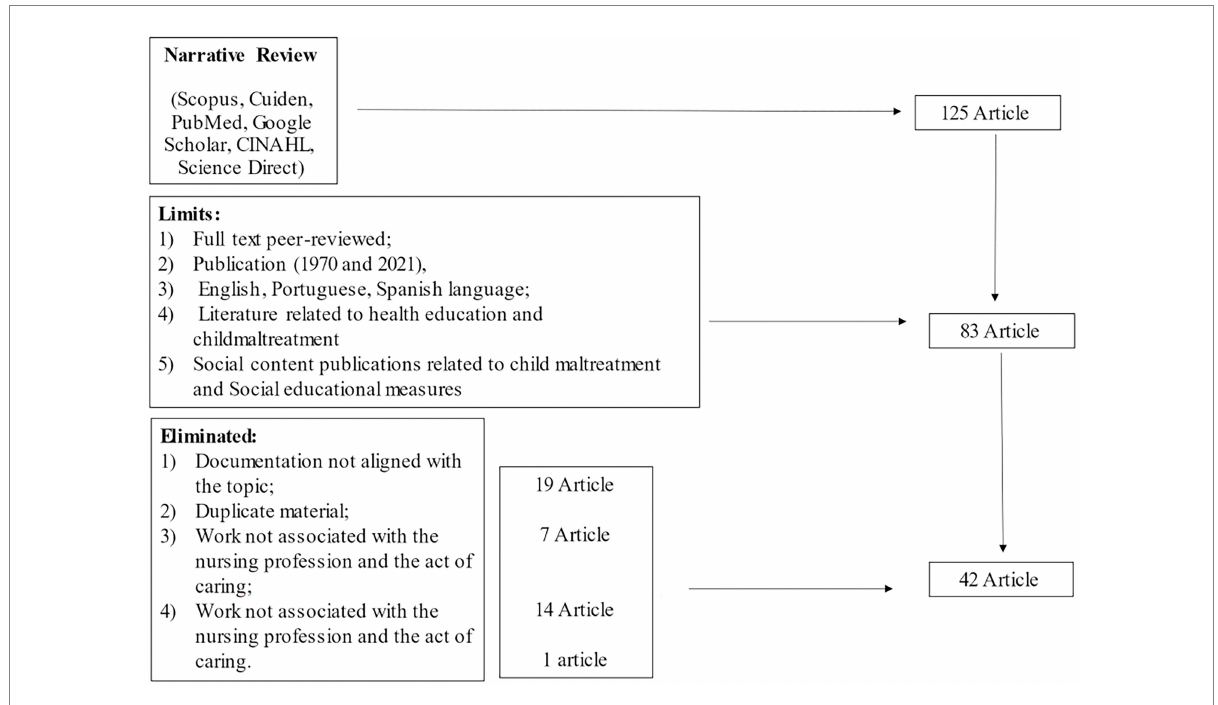
FIGURE 2 Article filtering strategy (Author’s own